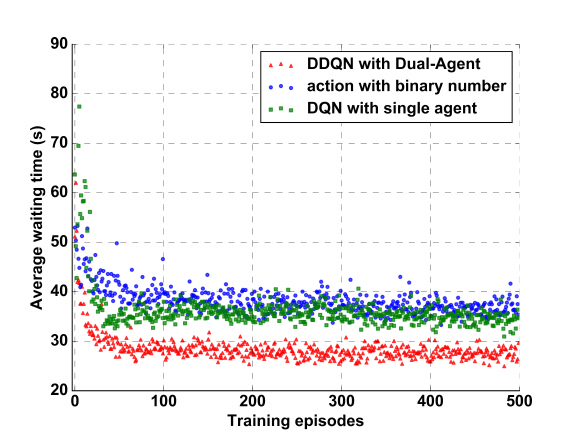
Figure 7. Average waiting time when the dual-agent control method, DQN algorithm, and control algorithm with binary action are used.